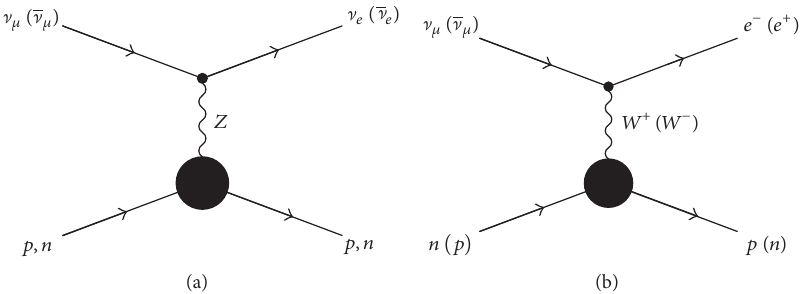
Figure 1: Diagrams of nonstandard neutrino-nucleon interactions for neutral-current (a) and charged-current (b)